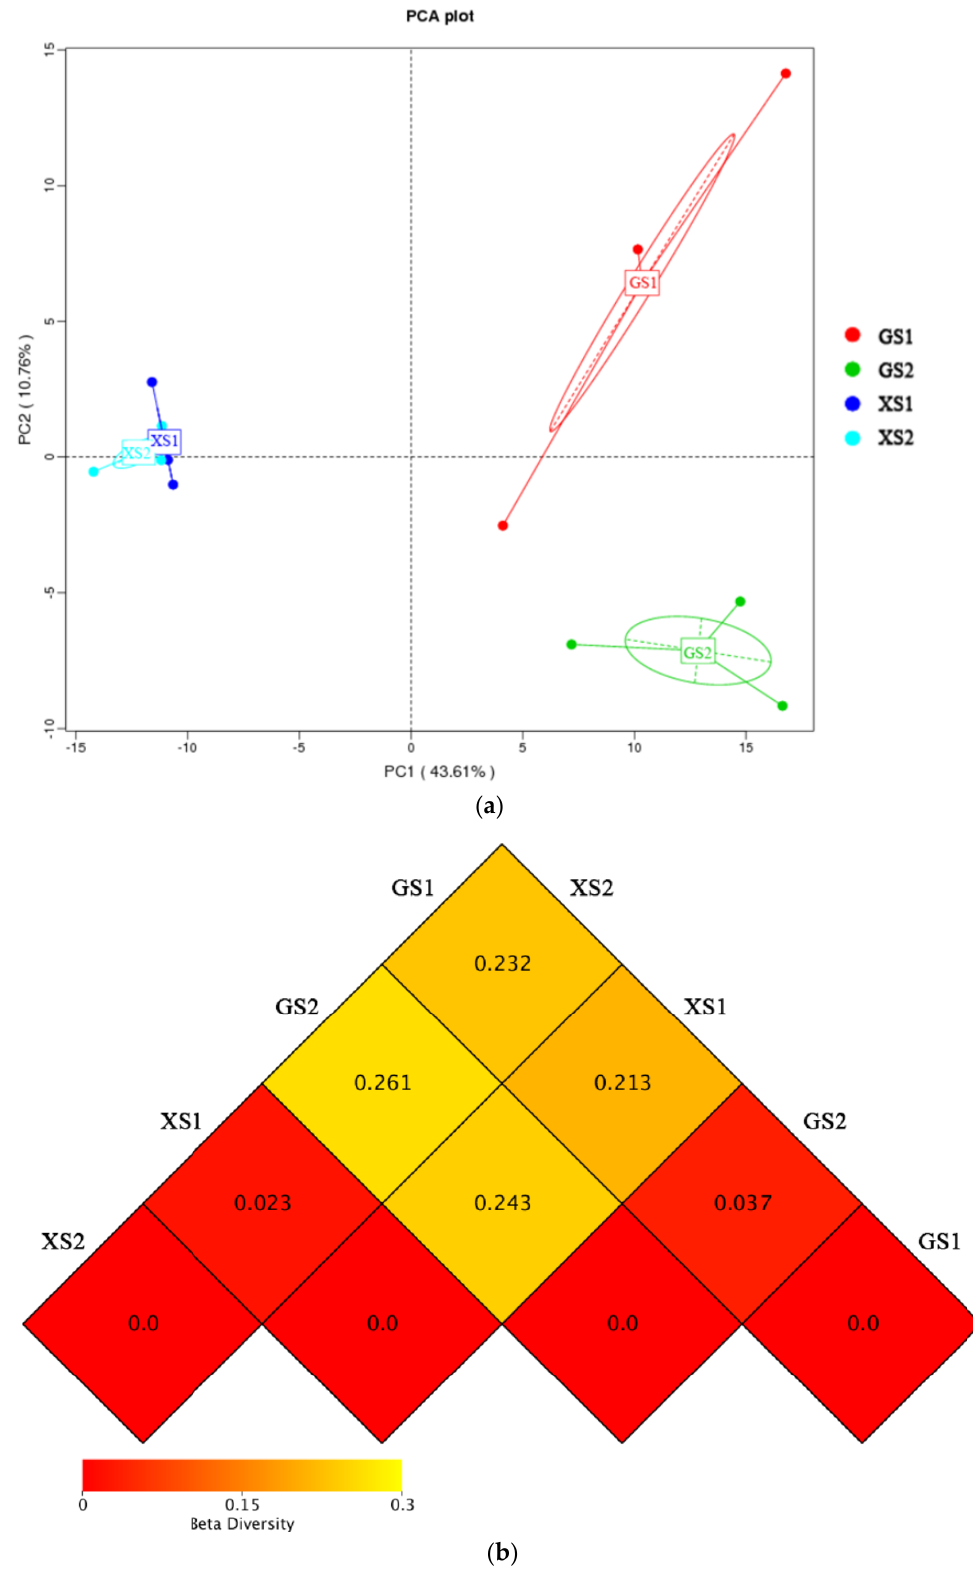
Figure 8. Beta diversity of the sourdough (( a ): principal correspondence analysis (PCA); ( b ): heat